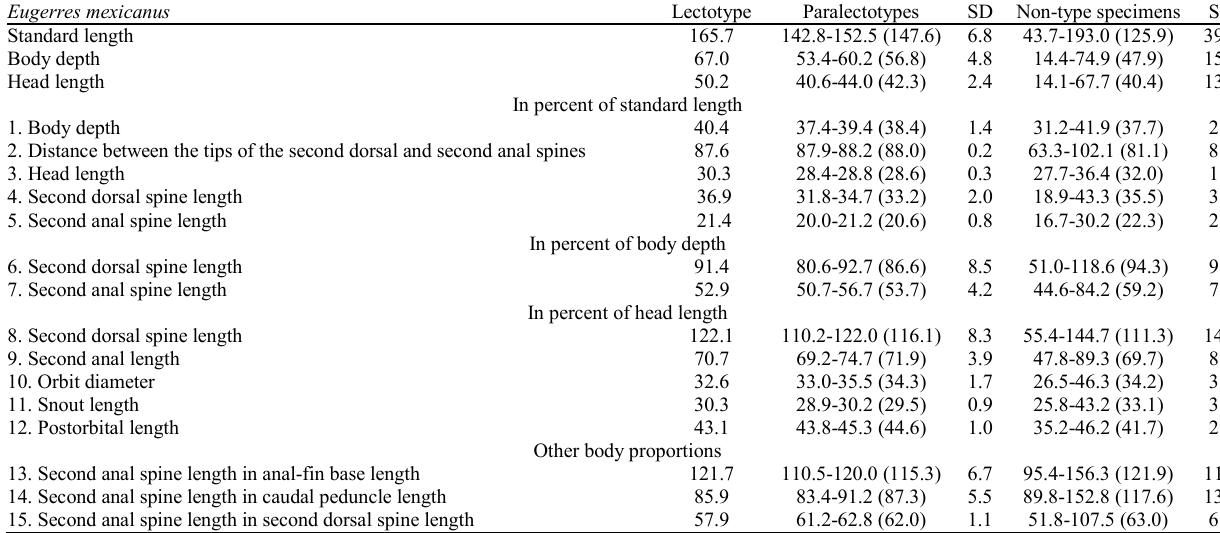
Table 2. Morphometric data for Lectotype, two Paratypes, and 122 non-type specimens of Eugerres mexicanus . Standard